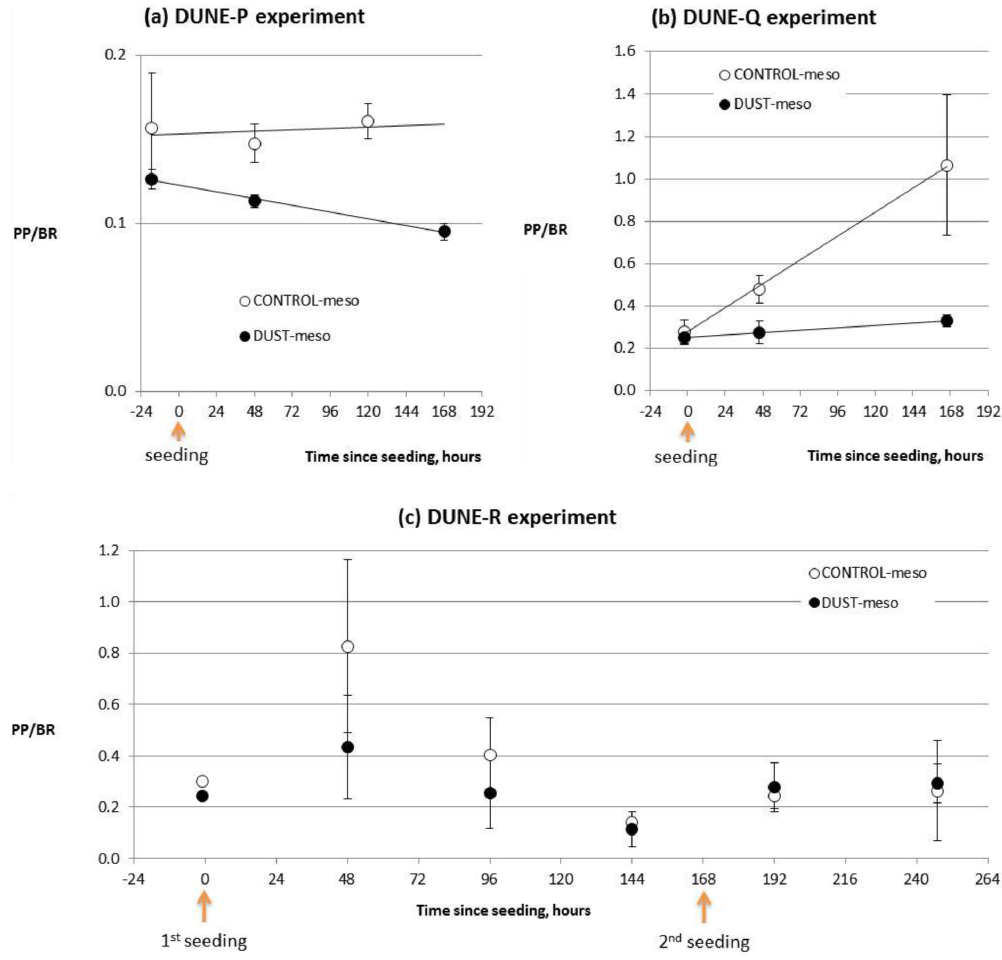
Figure 1. Evolution of the ratio PP/BR in CONTROL-MESO and after seeding in DUST-MESO (a) during DUNE-P experiment, (b) Q experiment and (c) R experiment. Vertical arrows indicate seeding time (time origin for DUNE-P, -Q, and -R1, 168h for